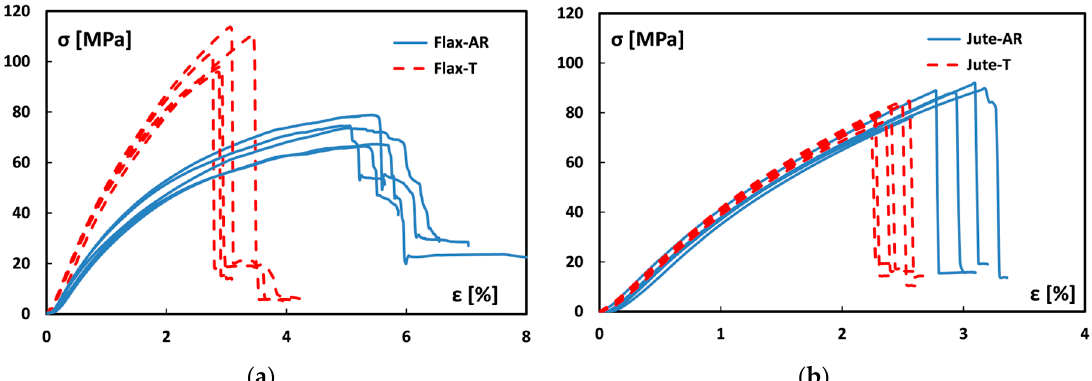
Figure 4. Distribution of stress-strain flexural curves of ( a ) flax and ( b ) jute laminates.